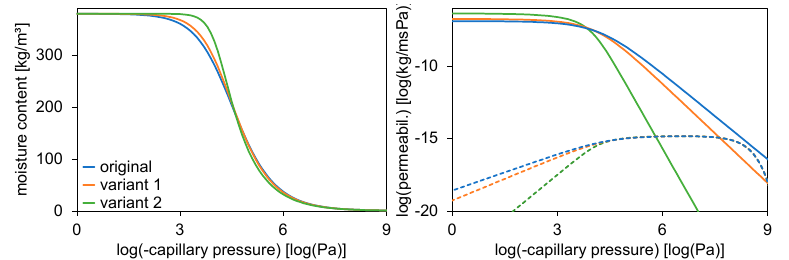
Figure 3. ( left ) Moisture retention curves of the original OPS limestone and two variants; ( right ) liquid and vapour permeability (both related to gradients in capillary pressure) curves of the original OPS limestone and two variants.